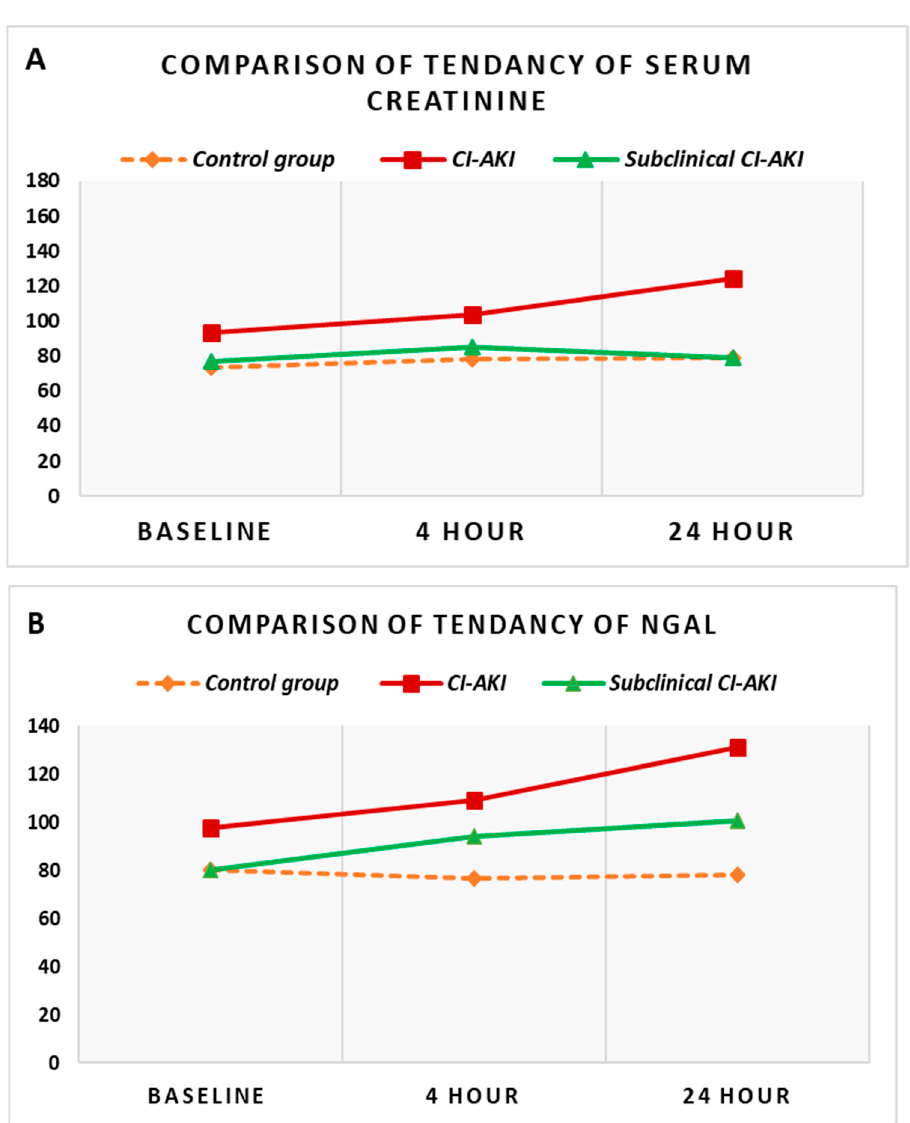
Figure 3. Comparison of dynamic changes in serum creatinine ( A ) and plasma NGAL ( B ) in the di ff erent groups. Control group versus CI-AKI group—creatinine—baseline ( p = 0.005), 4th hour ( p < 0.001), 24th hour ( p < 0.001); NGAL—baseline ( p = 0.072), 4th hour ( p = 0.001), 24th hour ( p = 0.005); control group versus group of subclinical CI-AKI—creatinine—baseline ( p = 0.625), 4th hour ( p = 0.458), 24th hour ( p = 0.928); NGAL—baseline ( p = 0.899), 4th hour ( p = 0.024), 24th hour ( p = 0.086); CI-AKI versus subclinical CI-AKI—creatinine—baseline ( p < 0.05), 4th hour ( p < 0.05), 24th hour ( p < 0.05); NGAL—baseline ( p = 0.088), 4th hour ( p = 0.354), 24th hour ( p = 0.164). CI-AKI (contrast-